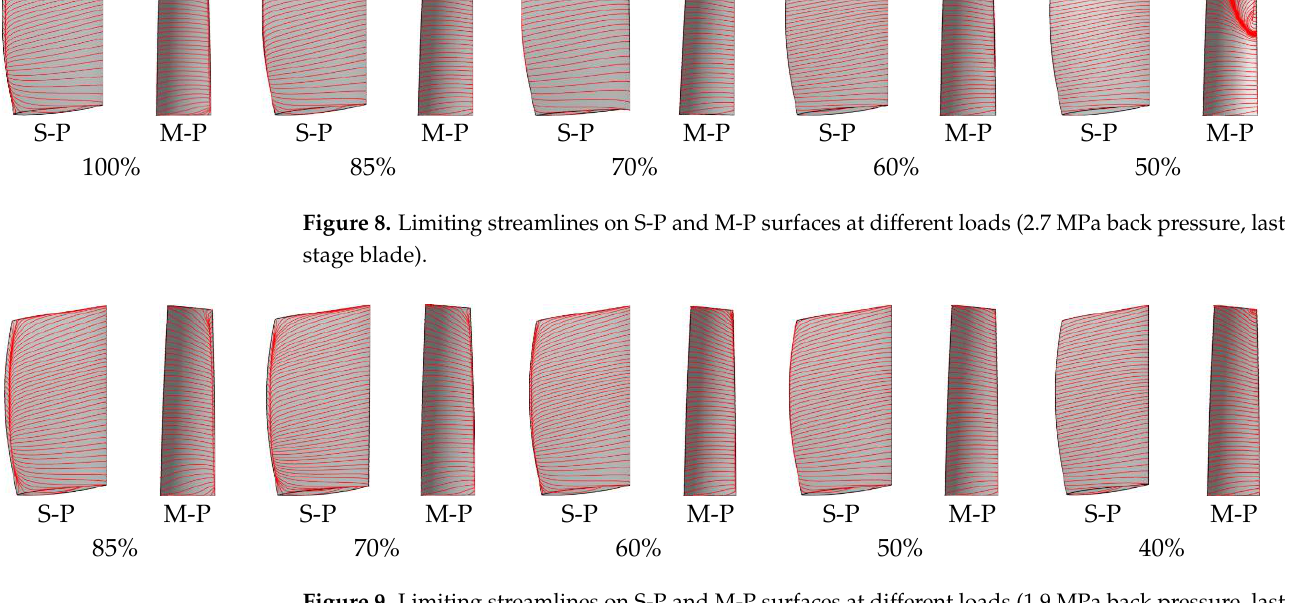
Figure 9. Limiting streamlines on S-P and M-P surfaces at different loads (1.9 MPa back pressure, last stage blade) .